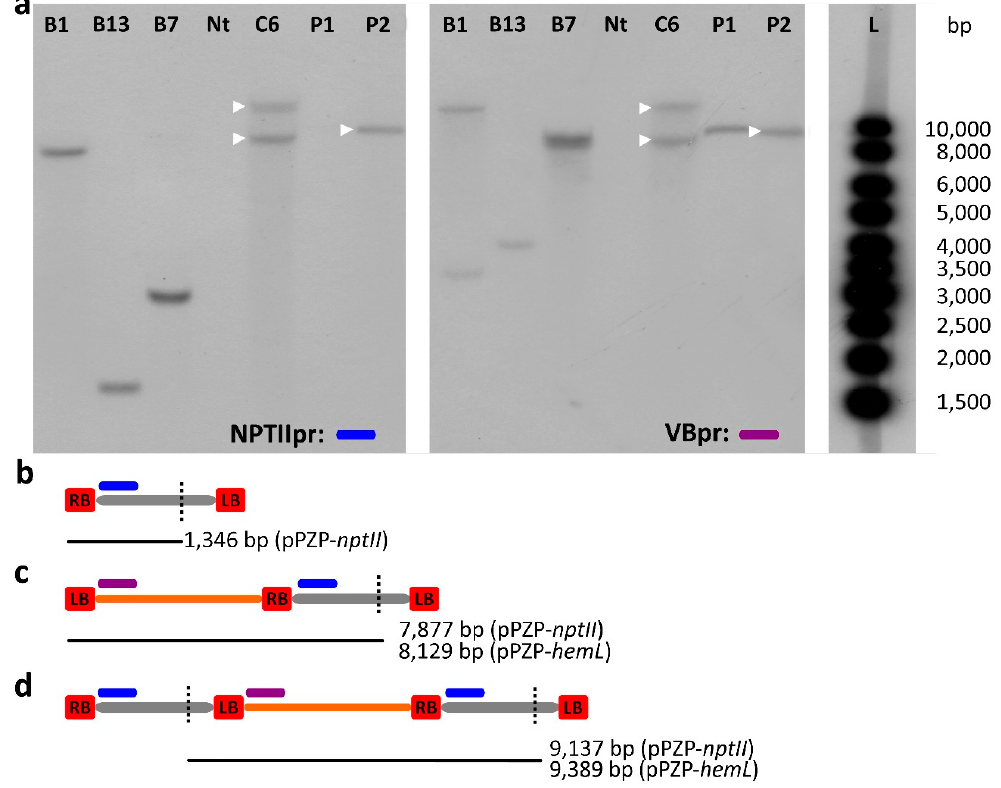
Figure 5. ( a ) Southern blot of genomic DNA extracted from T 1 B and C plants with probe NTPIIpr (blue segment) and VBpr (purple segment). The bands that hybridized to both probes are marked with a white triangle. Nt: non transgenic; P1: binary vector pPZP- hemL (linearized); P2: binary vector pPZP- nptII (linearized); L: 1 Kb ladder; ( b – d ) schemes (not in scale) of the restriction fragments produced by Nco I (black vertical dotted line) digestion ; ( b ) a canonical T-DNA processing; ( c ) wrong initiation at the LB and transfer of the whole VB along with a single copy of the T-DNA; ( d ) correct initiation at the RB and an incorrect termination at the LB, resulting in the transfer of the whole VB sequence along with two T-DNA copies. The position of the probes and of the restriction sites, and the length of the restriction fragments are indicated.